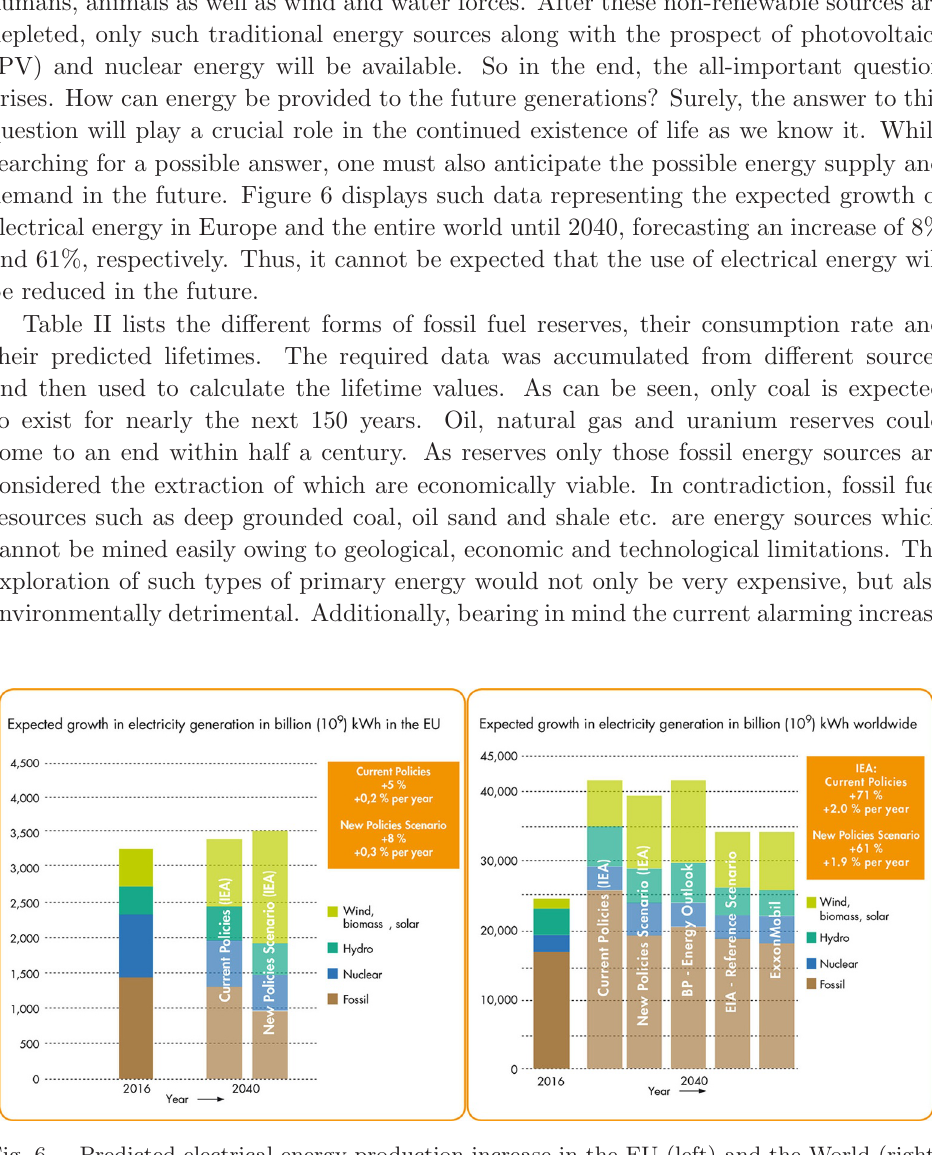
Fig. 6. – Predicted electrical energy production increase in the EU (left) and the World (right) with calculations adopted from